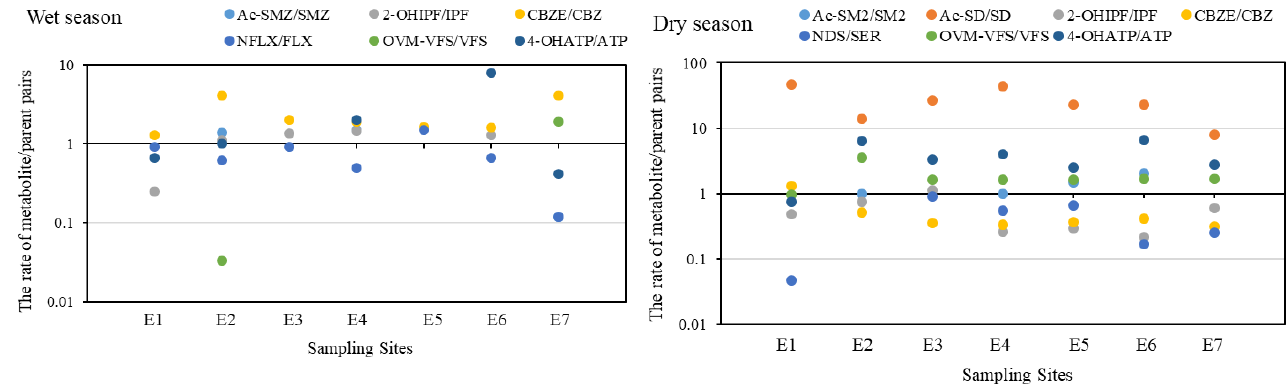
Figure 3. The concentration rates of metabolite/parent pairs in different sites in the water of Yunliang river in the wet and dry seasons.